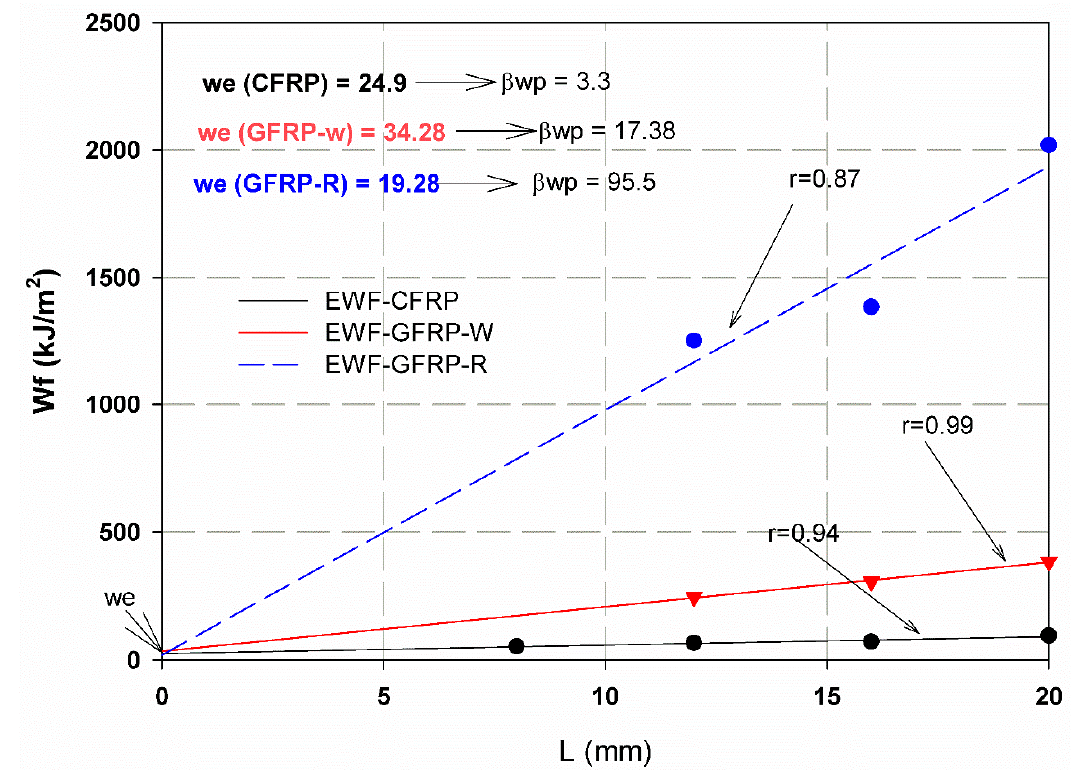
Figure 13. Energy and ligament relation for EWF approach.